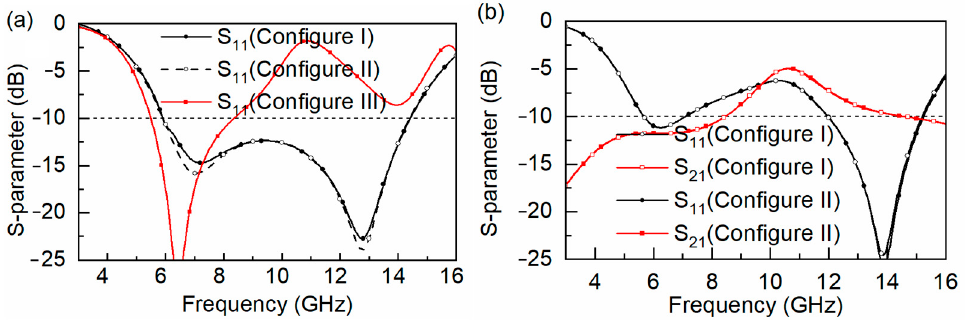
Figure 3. ( a ) S 11 when lossless FSS is replaced by ground plane ( b ) S 11 and S 21 under Configuration I and II with lossless FSS.